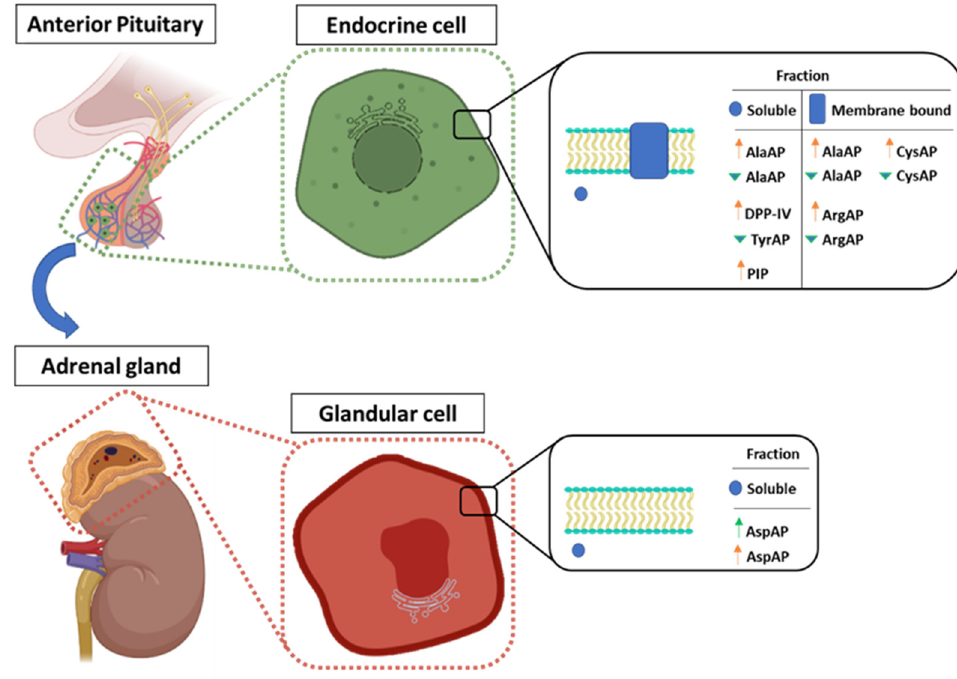
Figure 6. Summary diagram of the modified enzyme activities in the soluble and membrane-bound fractions of the anterior pituitary (adenohypophysis) and the adrenal gland. The green and orange arrows indicate diets with olive oil (VOO) and butter plus cholesterol (Bch), respectively. The arrow ( ↑ ) represents significant differences of a high-fat diet compared to the standard diet (S) (VOO or Bch vs. S). The arrowhead ( ▼ ) represents significant differences between high-fat diets (VOO vs. Bch).